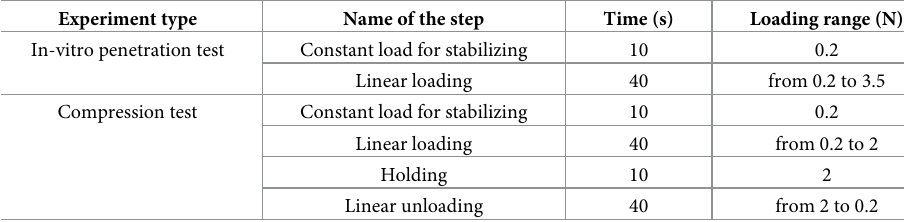
Table 1. The in-vitro and compression test